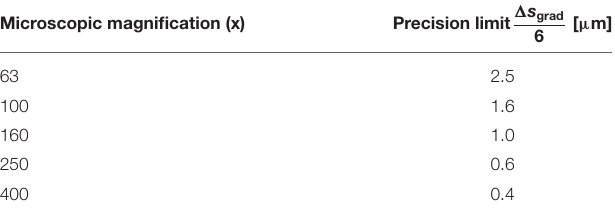
TABLE 2 | Precision limits of microscopic size measurements are derived from the distance between two graduation marks of the ocular micrometer used, and therefore dependent on the microscopic